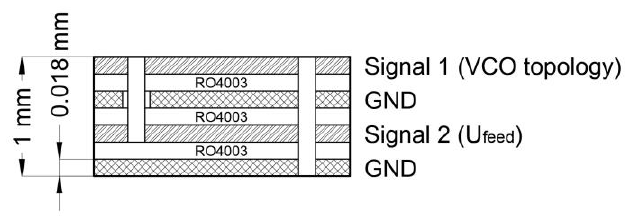
Fig. 2. ML PCB in cross-section.